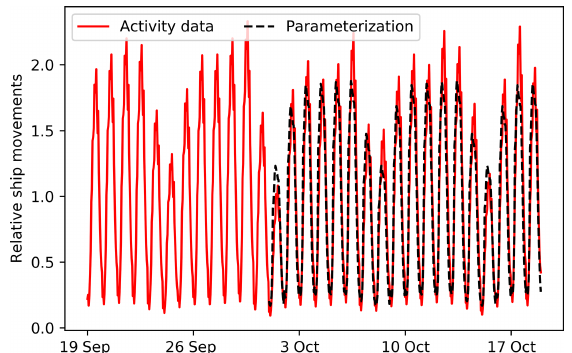
Figure 6. Daily time profiles for shipping. Solid red line is based on true activity data, whereas dashed black line is a parameterization based on traffic counts of heavy-duty vehicles (diurnal cycle) and cars (day-to-day variations) on